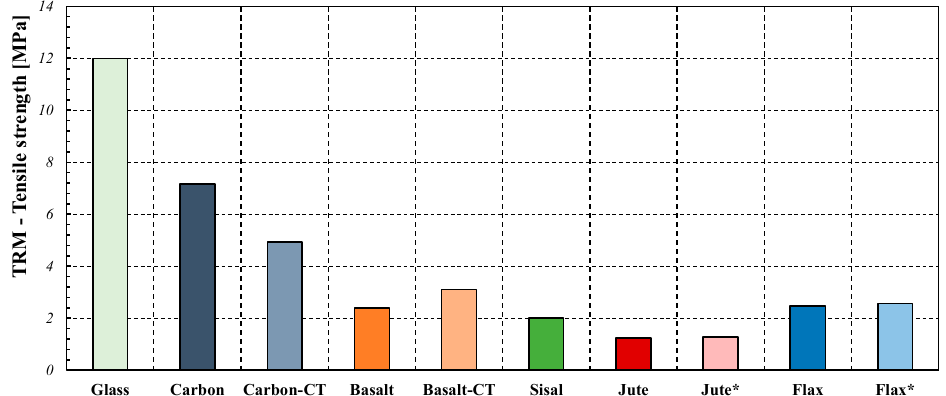
Figure 18. Comparison between different FRCM tensile strength. * Present Study.